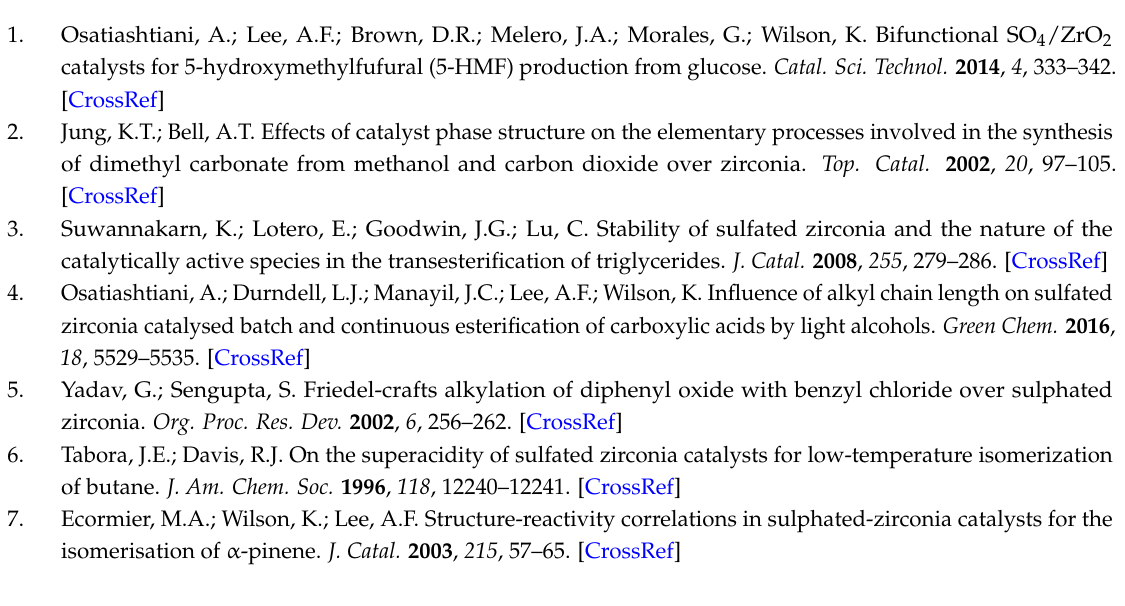
Table S1: Sulfate configuration and associated vibrational frequencies of IR active modes from [1]. Figure S1: Evolved H 2 O ( m/z = 18 amu) during thermal analysis of parent and sulfated zirconia as a function of bulk S loading. Figure S2: (a) S 2p and (b) O 1s XP spectra for parent and sulfated zirconia as a function of bulk S loading. Figure S3: In situ IR ν CCN spectra of irreversibly adsorbed pyridine at 100 ◦ C on parent and sulfated zirconia as a function of bulk S loading. Figure S4: TPD profiles of adsorbed n-propylamine monitoring the release of reactively formed propene on parent and sulfated zirconia as a function of bulk S loading. Figure S5: Difference IR gas phase spectra following MBOH(g) adsorption over the parent zirconia before and after heating at 200 ◦ C for 5 min. Figure S6: Propanoic acid conversion and mass-normalized rates of esterification of a fresh and recycled 1.7 wt % SZ